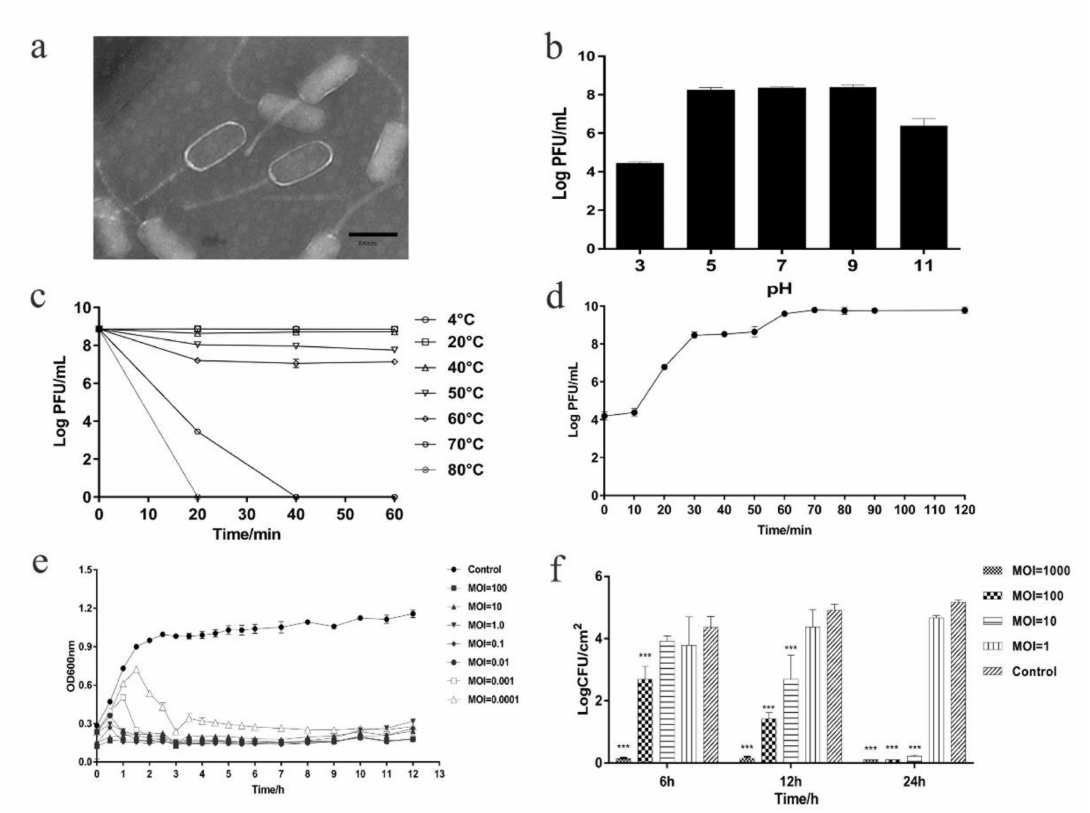
Figure 1. The characteristics of phage PHB08. ( a ) Electron microscopy of phage PHB08. Phage PHB08 has a rectangular head (length 124 mm ± 5, width 61 mm ± 5) and a long tail (158 mm ± 5). The scale in the right corner is 200 nm. ( b ) Stability of phage PHB08 at di ff erent pH values. ( c ) Stability of phage PHB08 at di ff erent temperatures. ( d ) Curves for one-step growth of phage PHB08. ( e ) Killing assay in tryptic soy broth (TSB) medium. ( f ) Killing assay in vegetable module. Data are expressed as